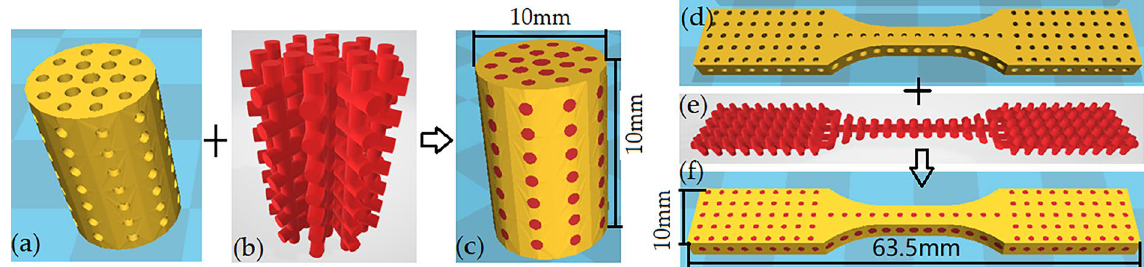
Figure 2. Designed model of the compressive scaffold: ( a ) PEEK, ( b ) PLA/WS/HA and ( c ) PEEK-PLA/WS/HA; and tensile scaffold: ( d ) PEEK, ( e ) PLA/WS/HA and ( f ) PEEK-PLA/WS/HA.